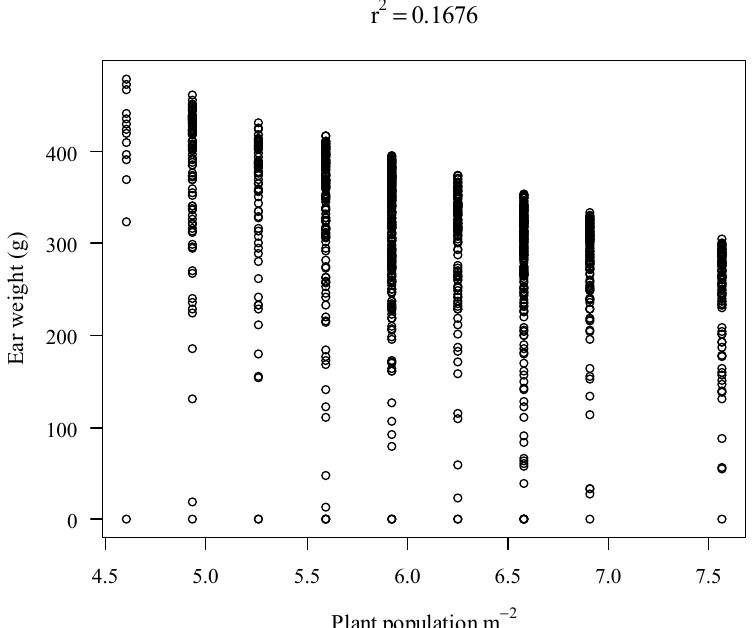
Figure 9. Simulation output for the mosaic size of 3.04 m 2 characterizing the relationship between the plant population and the ear weight.